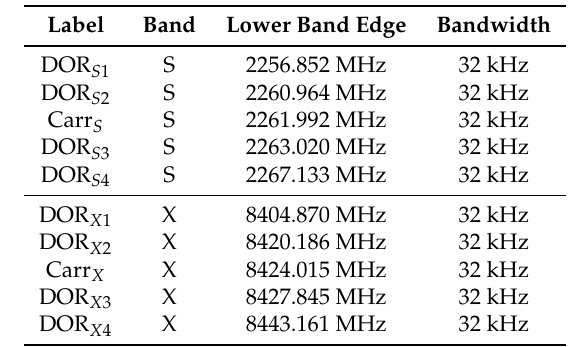
Table 3. List of the zoom-bands specified in DiFX for the correlation of APOD observations. The 32 kHz zoom-bands are centered on the APOD VLBI tones listed in Table 2.